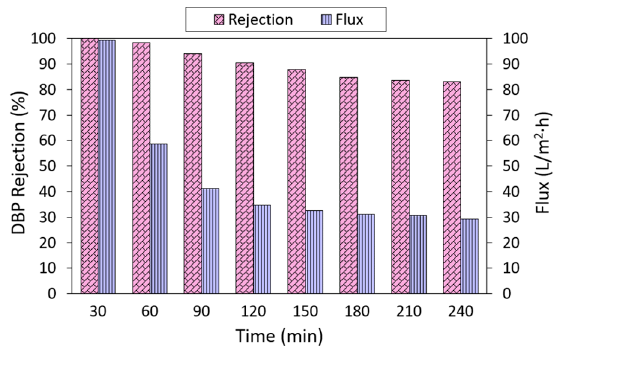
Figure 7. Concentration of DBP and BBP in the permeate of NF3 membrane.